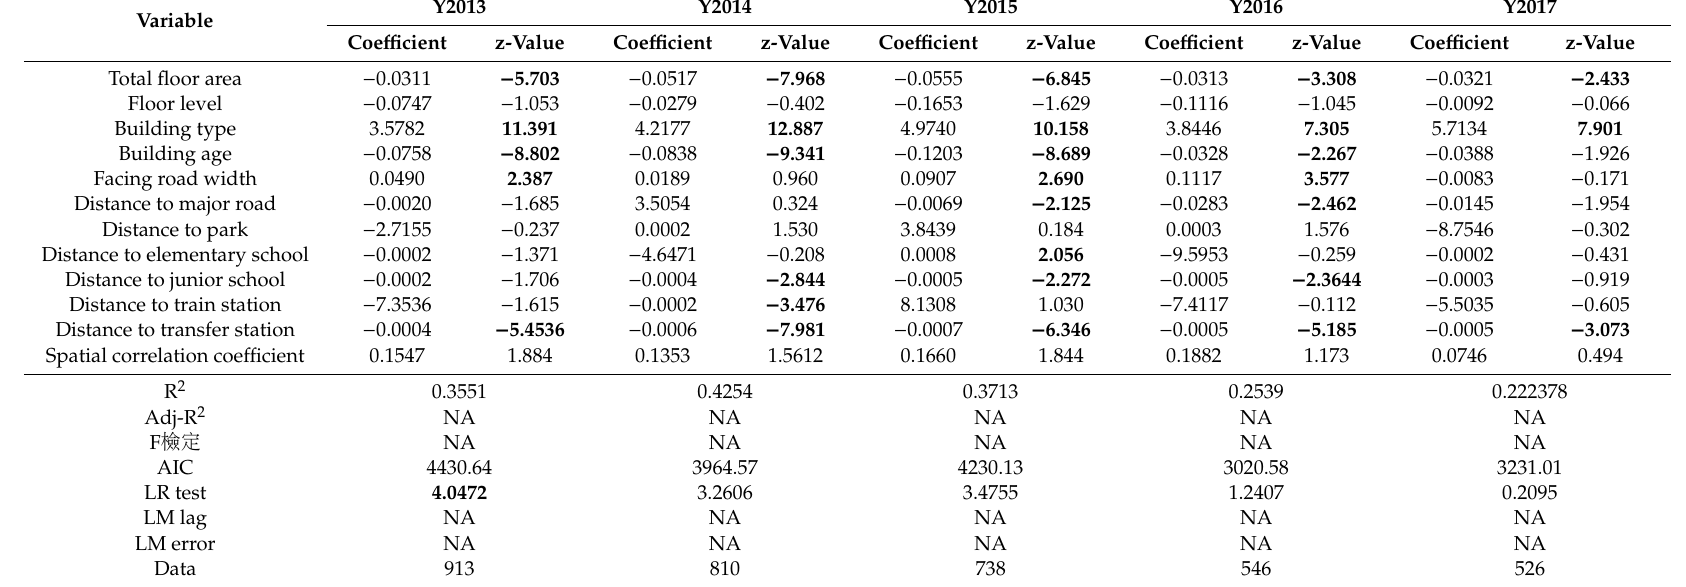
Table 4. The analysis results between 2013 and 2017 by the spatial error model